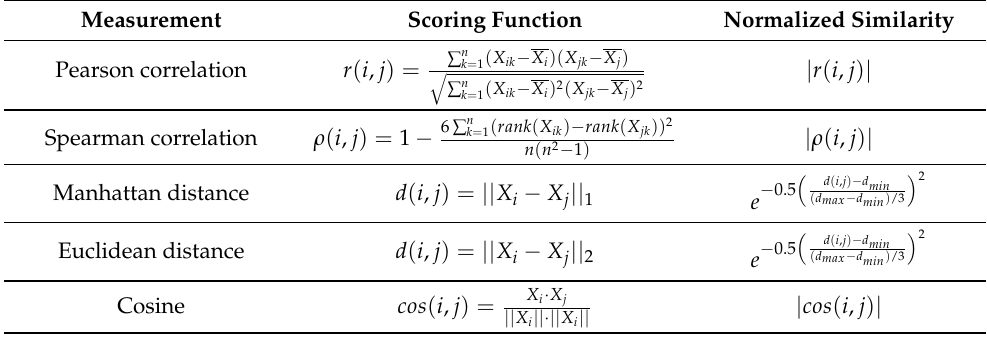
Table 1. Assume the 54-by-116 genetic-imaging matrix is X . Scoring functions are applied to X i and X j ∈ R 116 , 116-dimensional row vectors of X that maps the effect of a given SNP to 116 brain regions of interest (ROIs). Assume X ik denotes the i -th row and k -th column entry of X . Note that the Manhattan distance and Euclidean distance need to be transformed to the corresponding similarity measures using a Gaussian radial basis function in the third column.